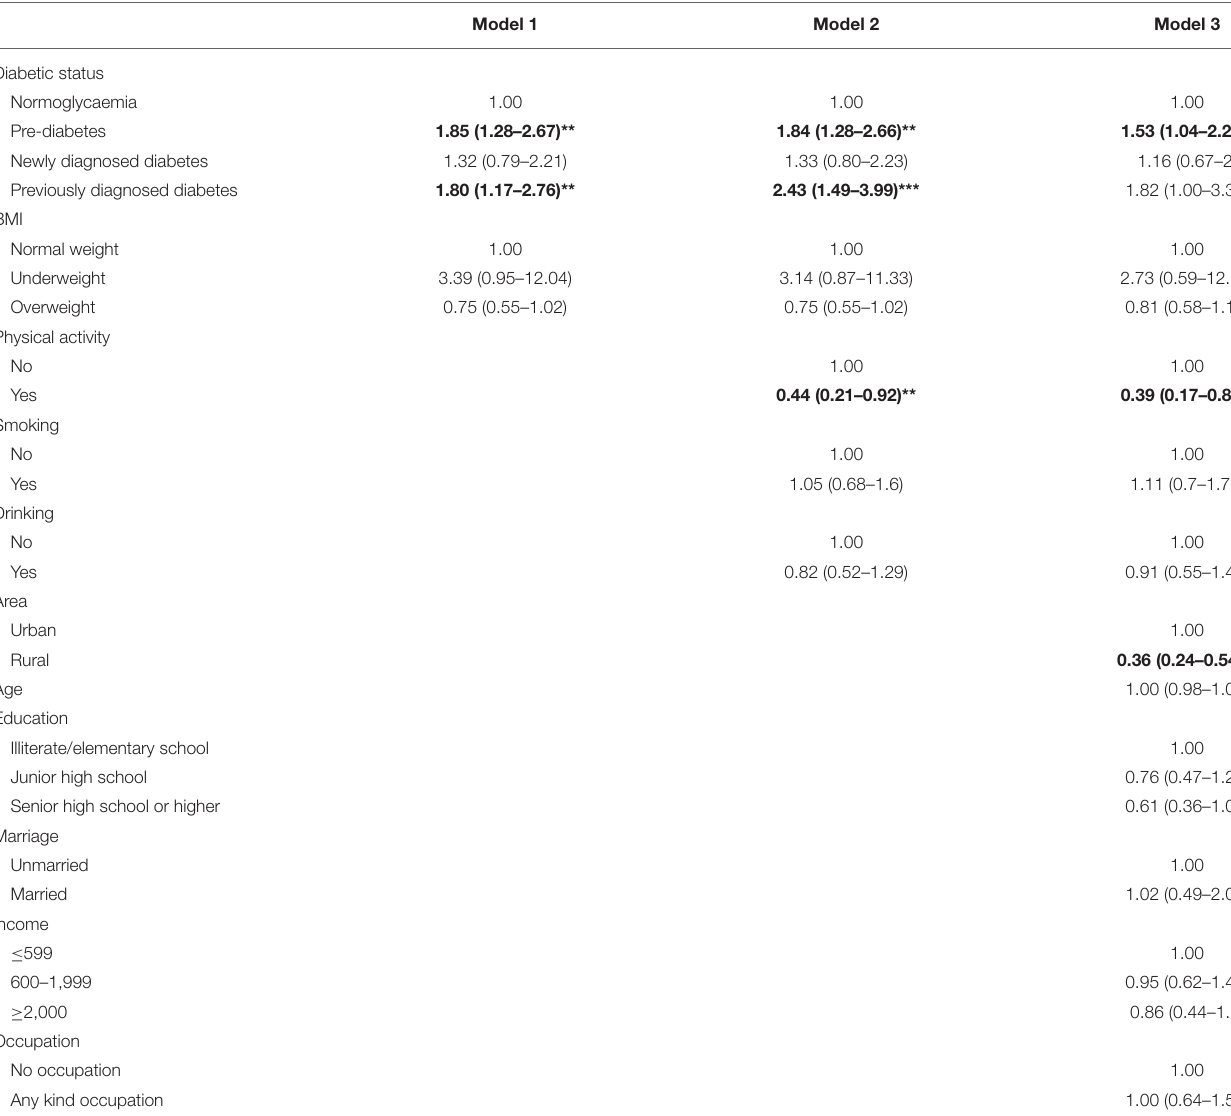
TABLE 4 | Odds ratio (OR) and 95% CI of health conditions, lifestyle factors for depression in all subjects in logistic regression models. Model